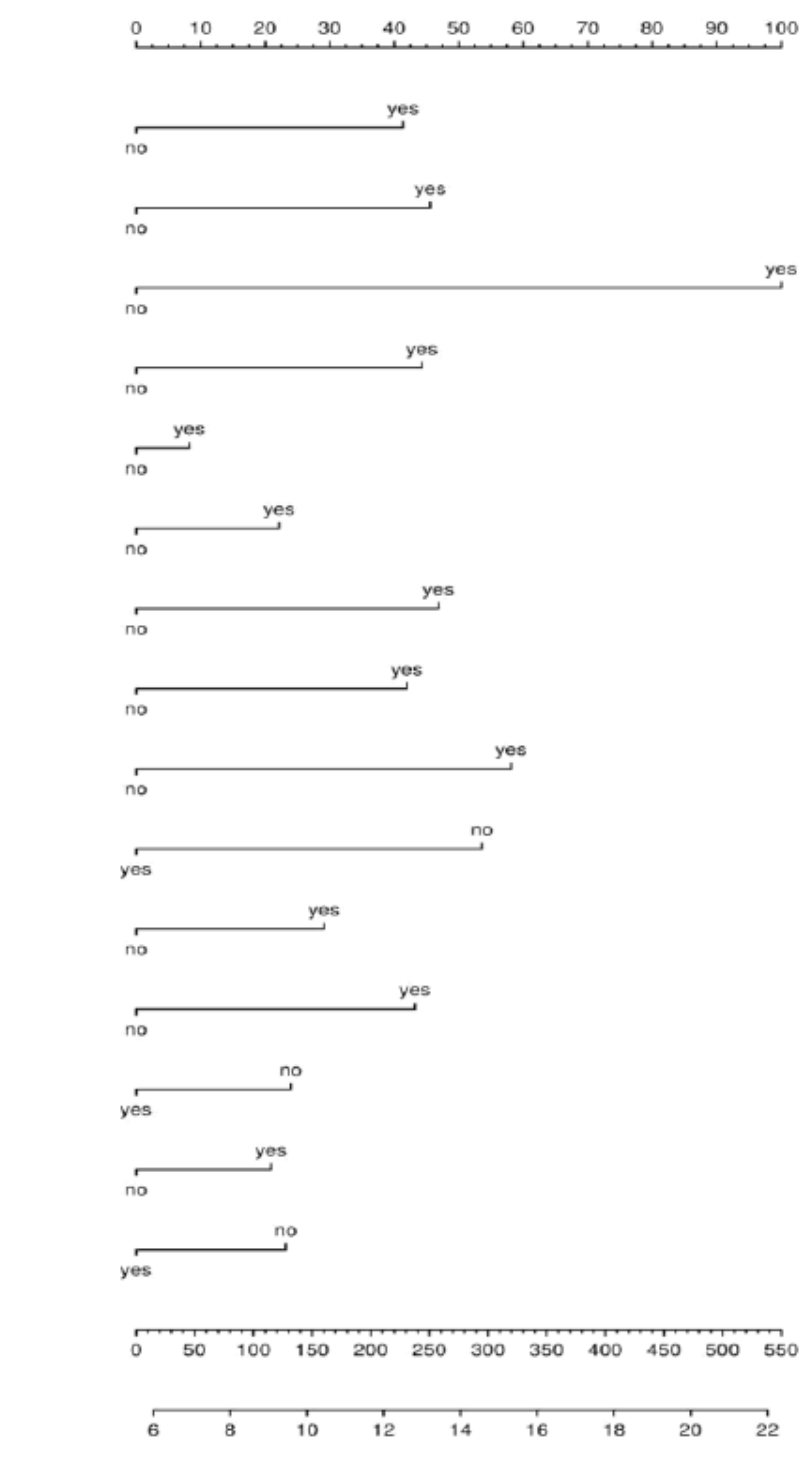
Figure A7. Nomogram IADL disability score at Figure 7. Nomogram IADL disability score at T0.